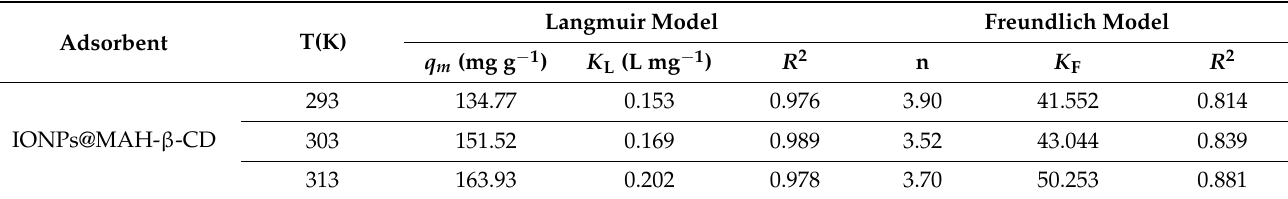
Table 1. The U(VI) adsorption isotherm parameters of IONPs@MAH- β